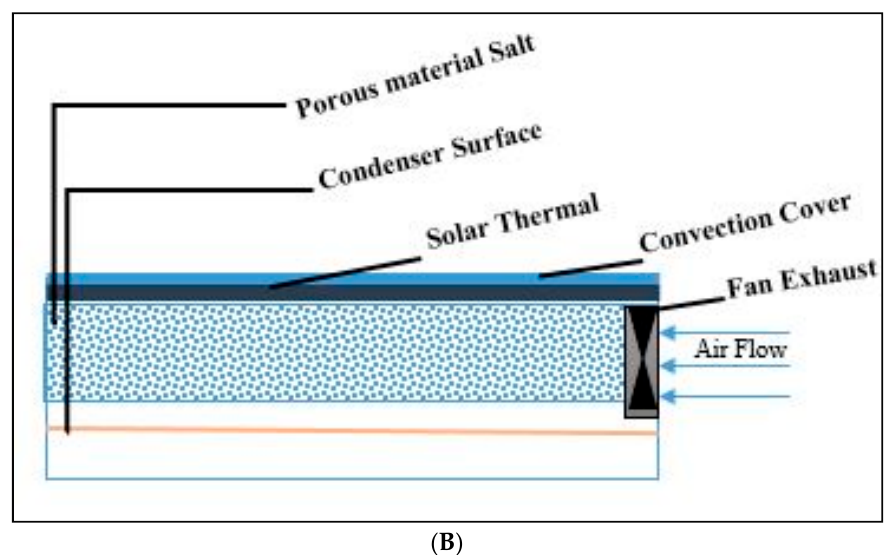
Figure 1. Schematic model of the water generation unit, using anhydrous salts, powered with solar power. ( A ): full design of the system; ( B ): focus on the porous material.